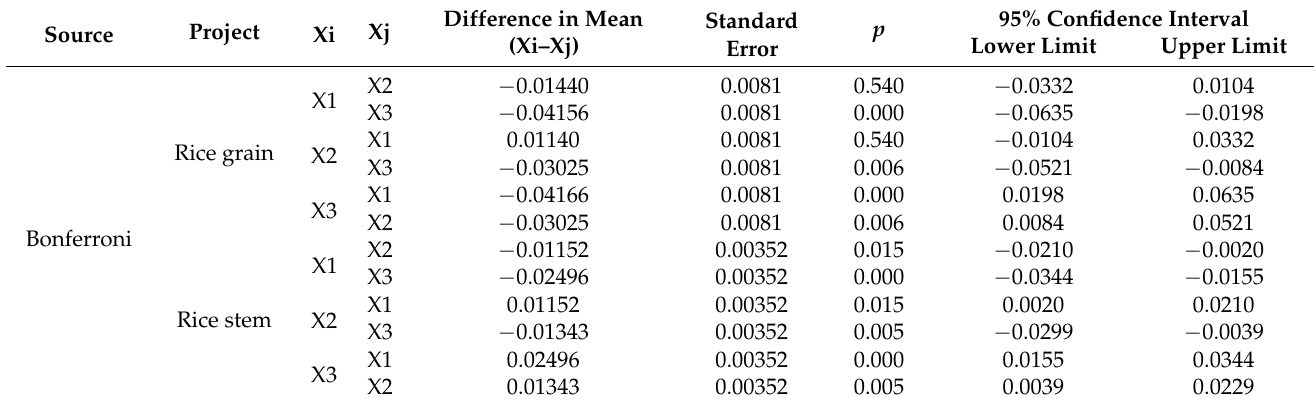
Table 5. Results of post hoc tests of the static friction coefficients of rice grains and stems.